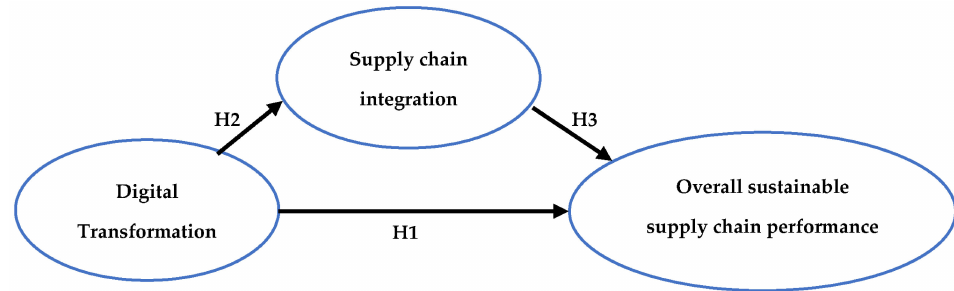
Figure 1. Conceptual